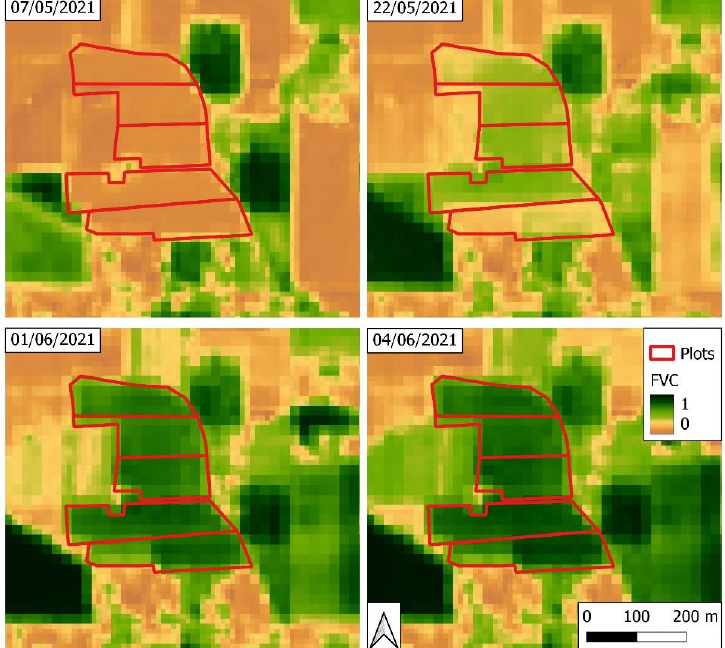
Figure 5. FVC maps derived from S2 acquisitions on 7 May 2021, 22 May 2021, 1 June 2021, and 4 June 2021 and the plot boundaries (in